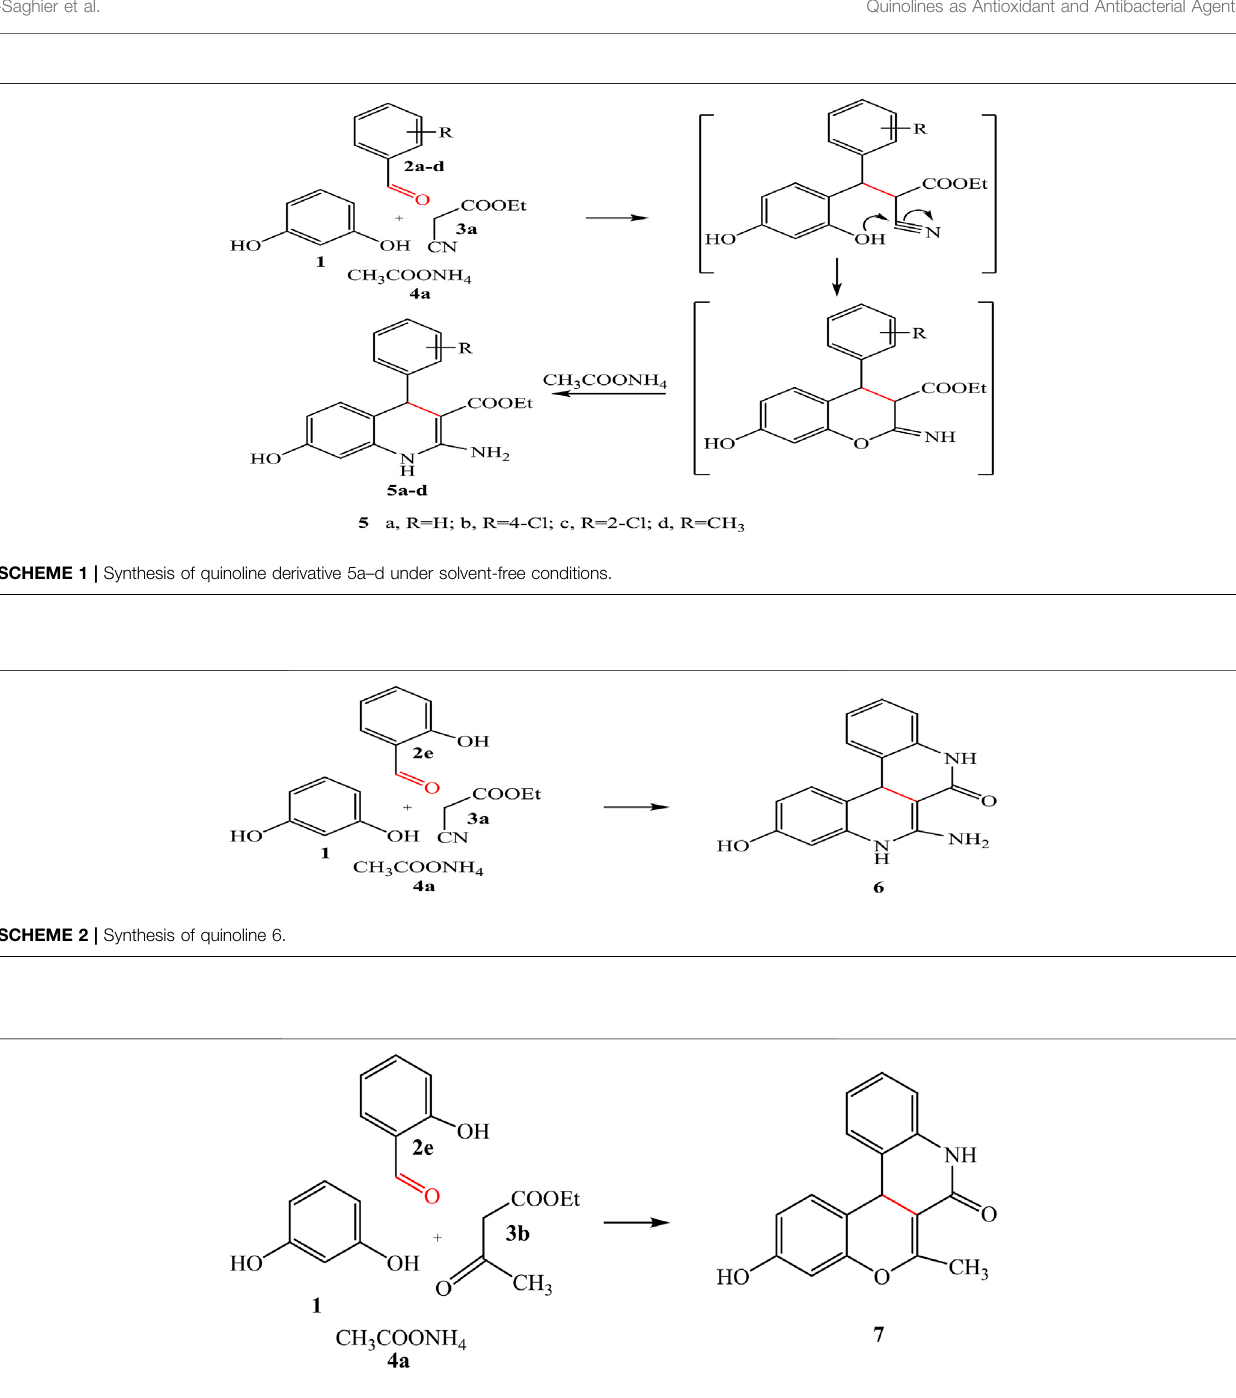
SCHEME 3 | Schematic representation of the synthesis of component 7.